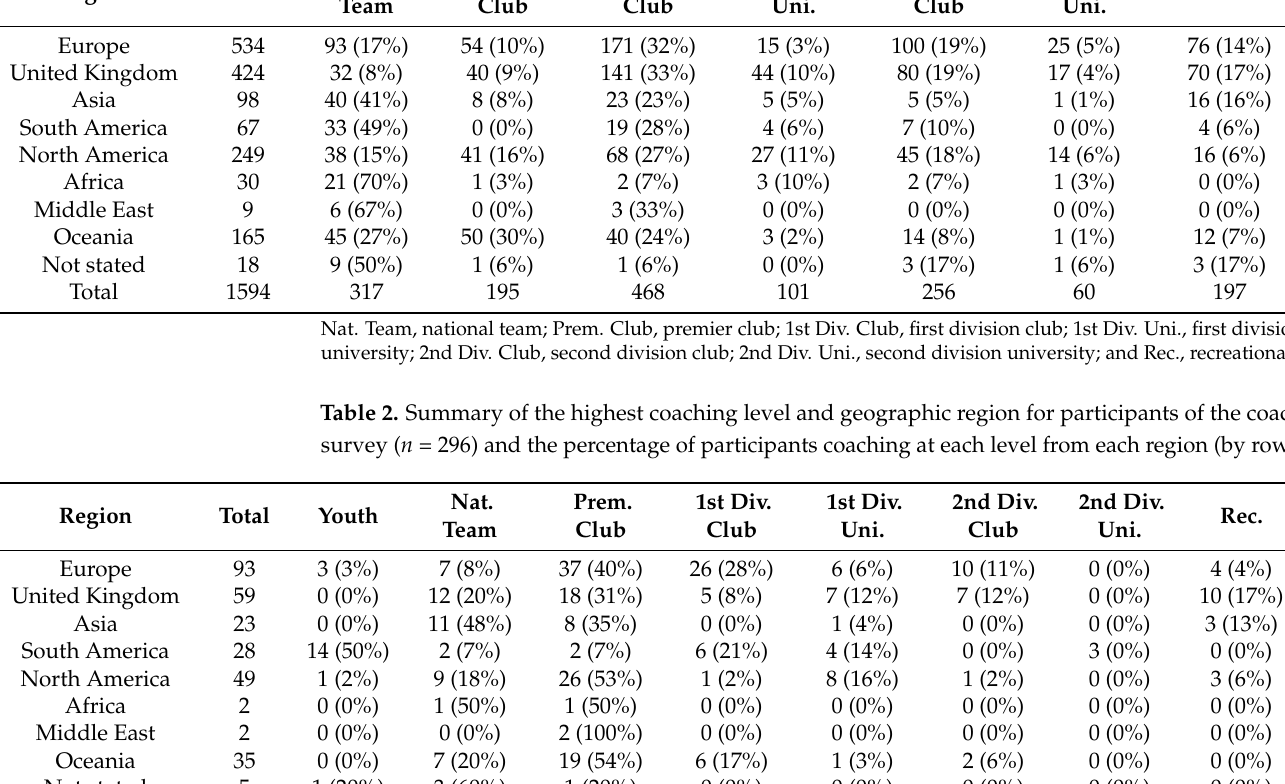
Table 1. Summary of the highest reported playing level and geographic region for participants in the player’s survey ( n = 1594) and the percentage of participants for each level by region (by row). Nat. Region Total